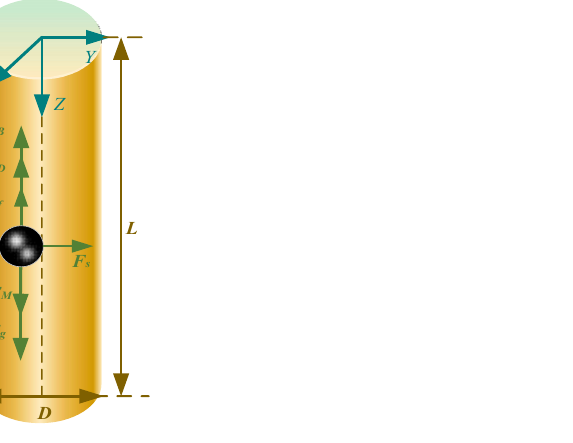
Figure 2. Diagram of the forces on a particle in a vertical pipe filled with oil.